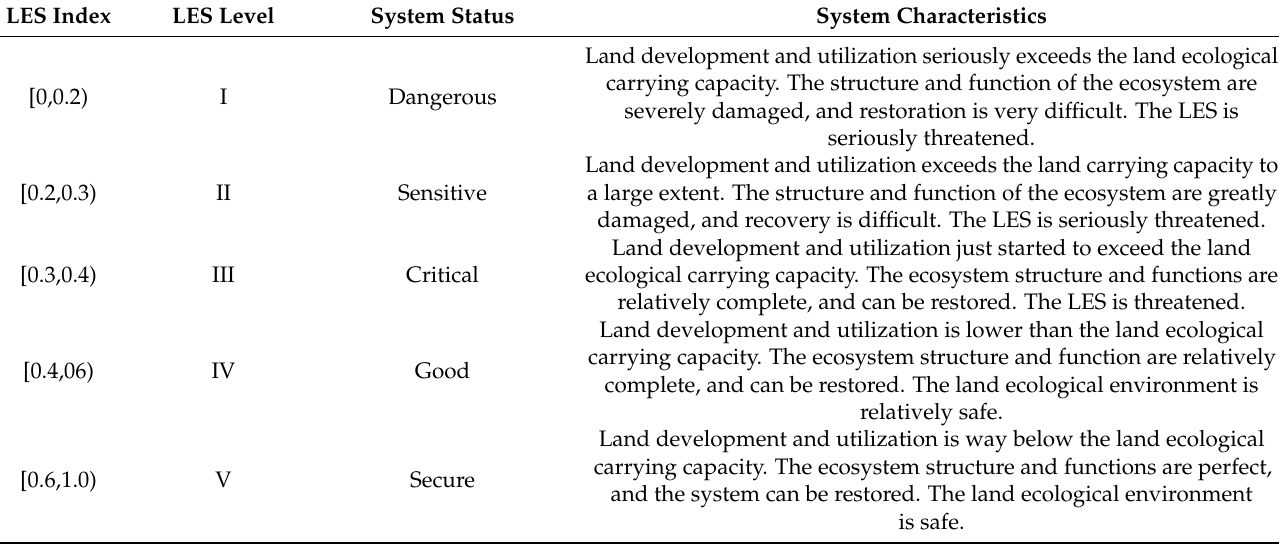
Table 2. Evaluation criteria of